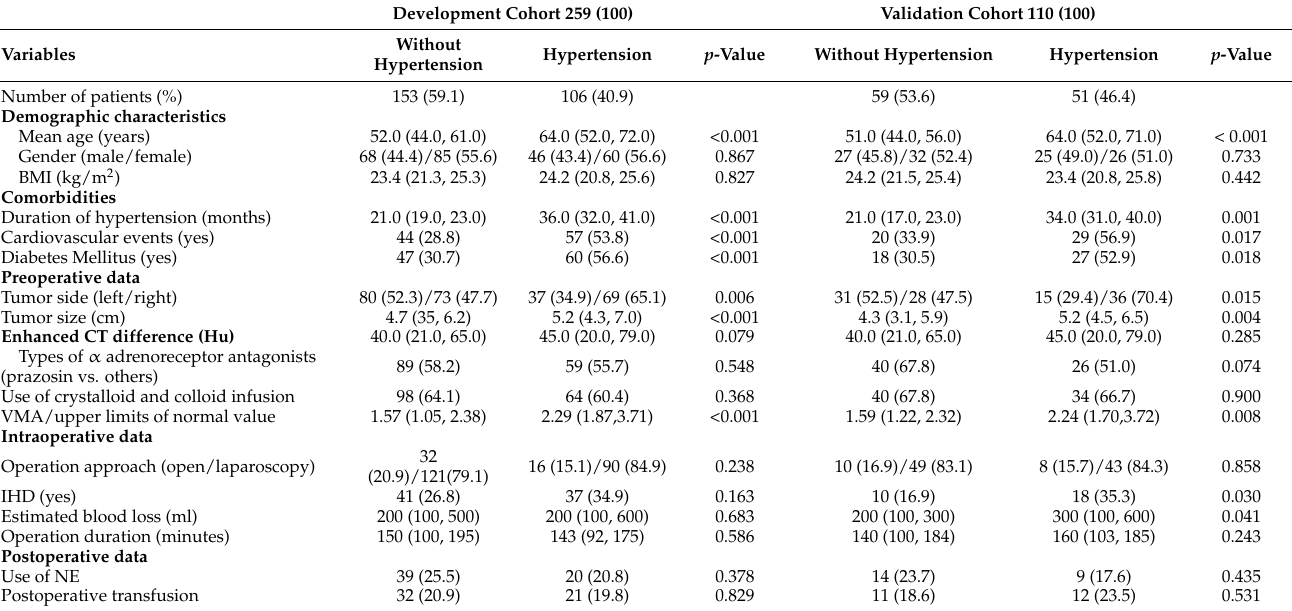
Table 2. Univariate analysis of patients in the development and validation cohort for this study.